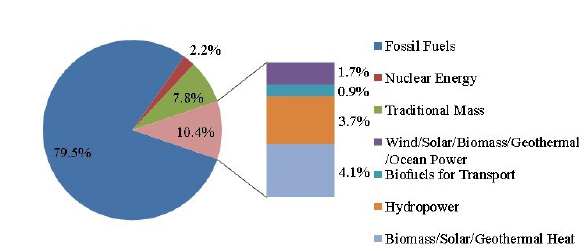
Figure 1. Total Energy Consumption (REN21,